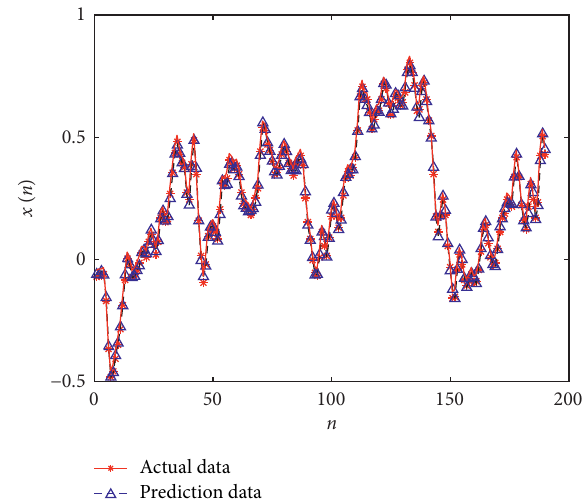
Figure 13: Prediction results of VMD-DE-ELM-ASVR. MAE � 0.010158; RMSE � 0.012886; R 2 �